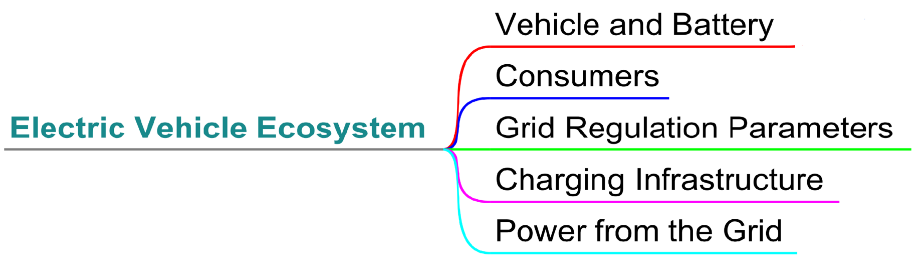
Figure 3. Stakeholders and components of an EV ecosystem.